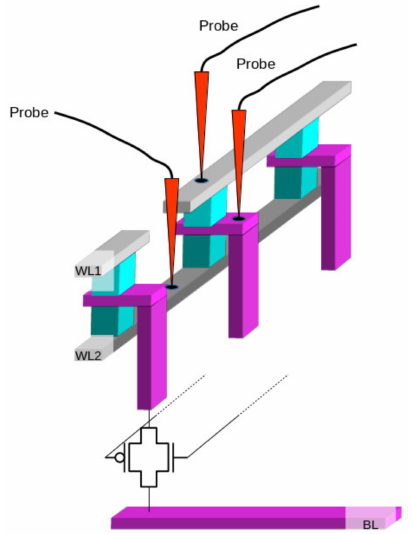
Figure 19. Measuring the two RRAM resistances of the serial cell requires access to line WL2 with a probe. In this configuration, it forces a cut in WL1 which will break the memory array